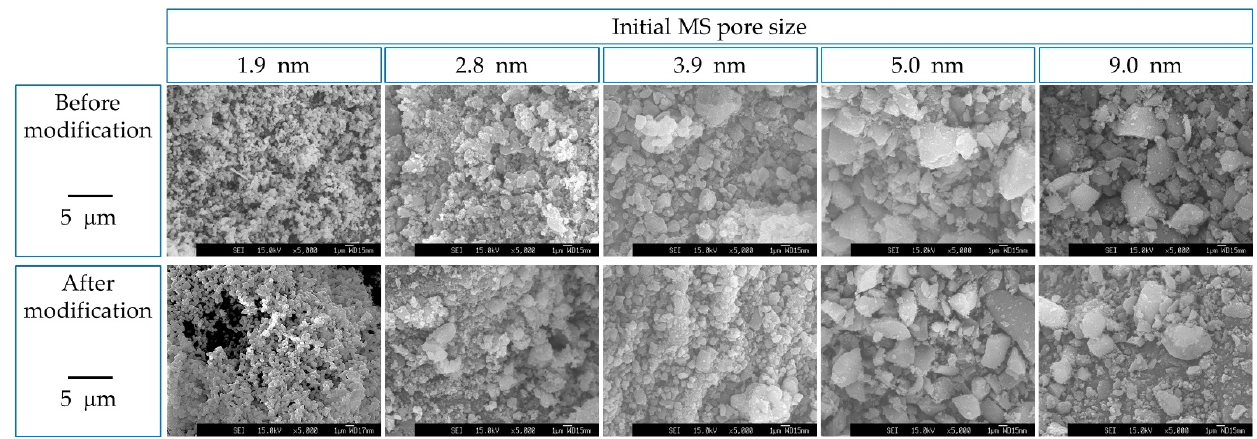
Figure 1. SEM image of MS before and after surface modification.